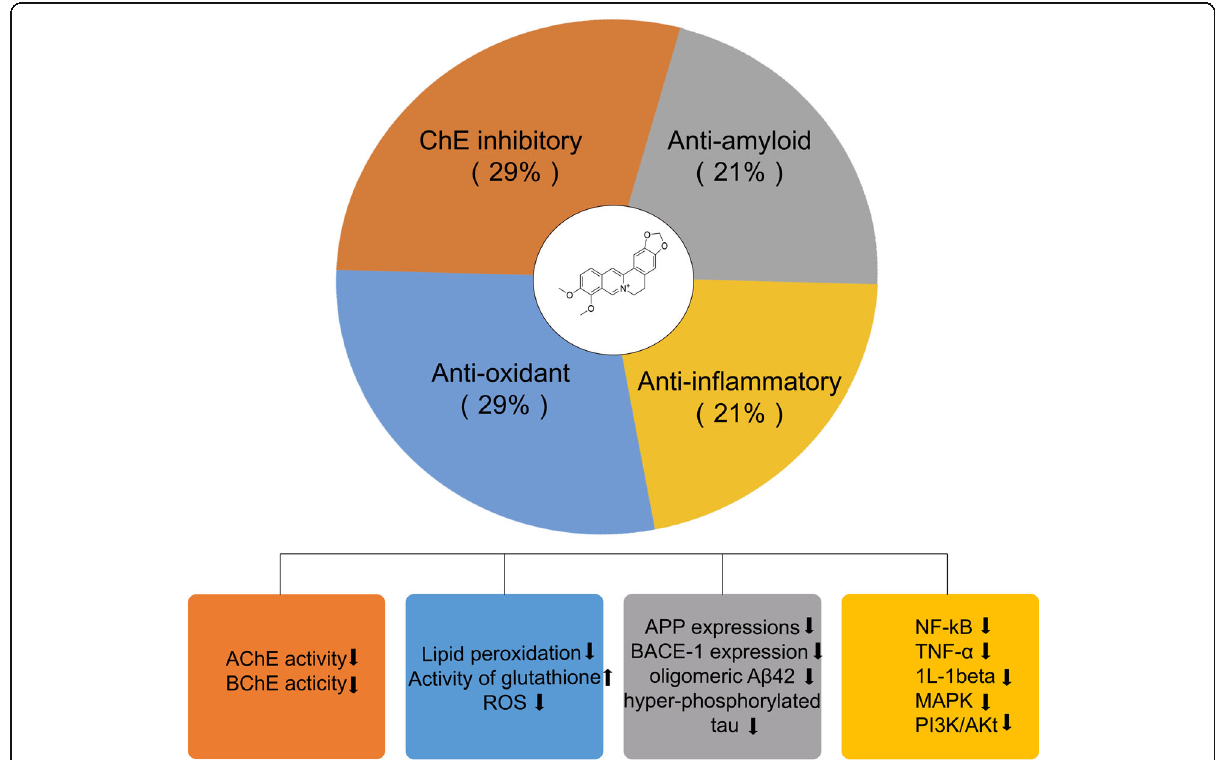
Fig. 3 Reported potential mechanisms underlying anti-AD property of